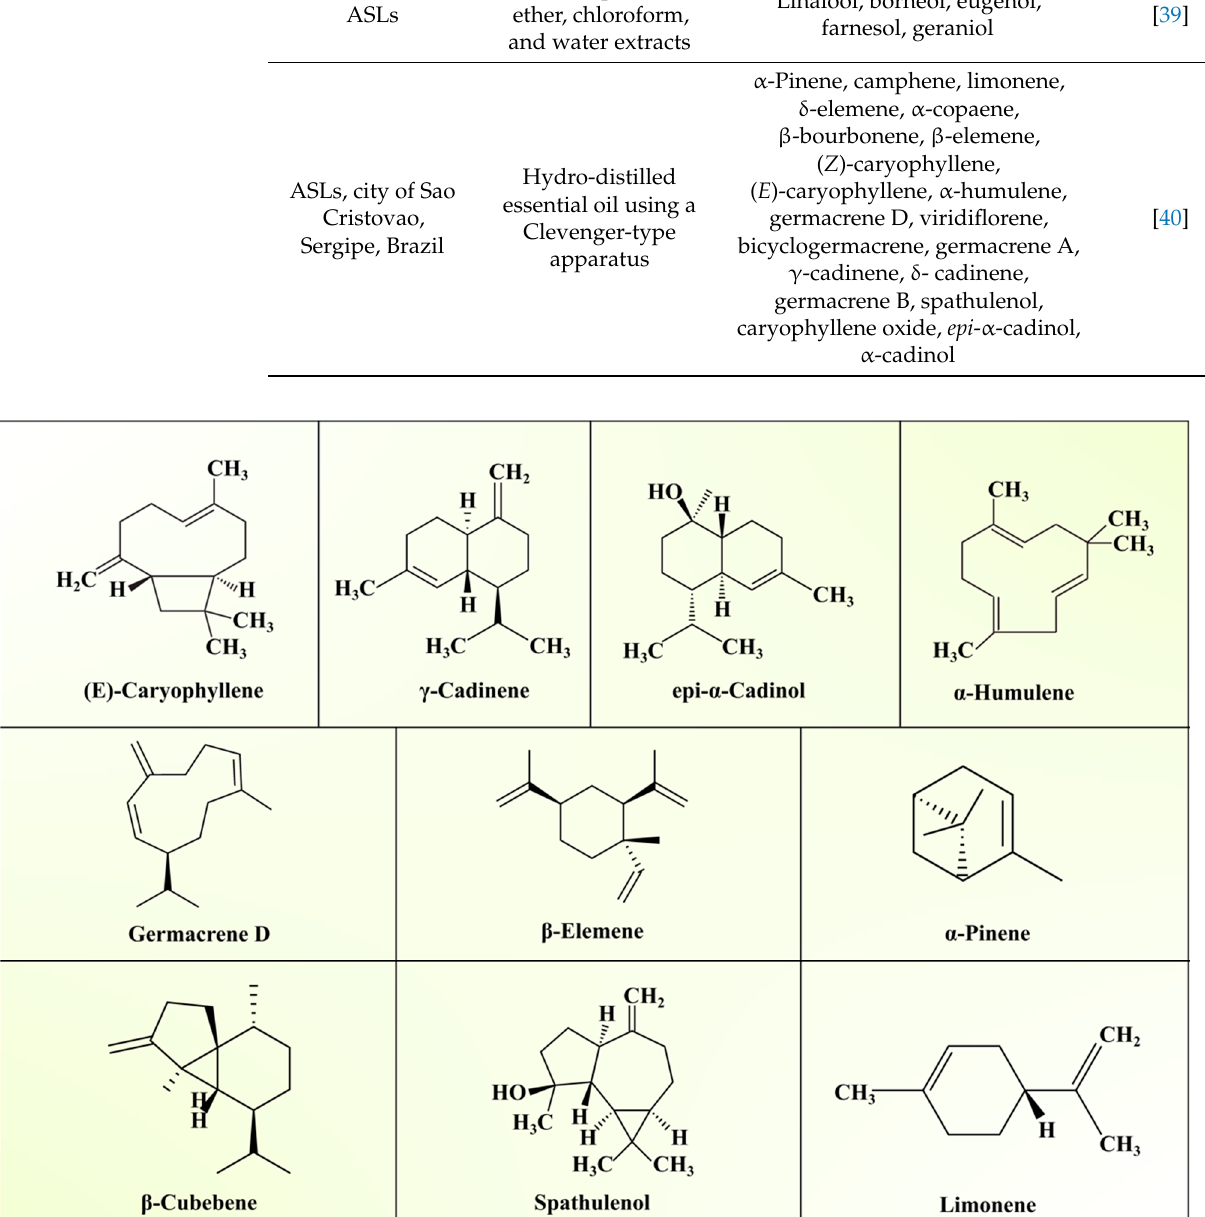
Figure 2. Major essential oil components in Annona squamosa L.